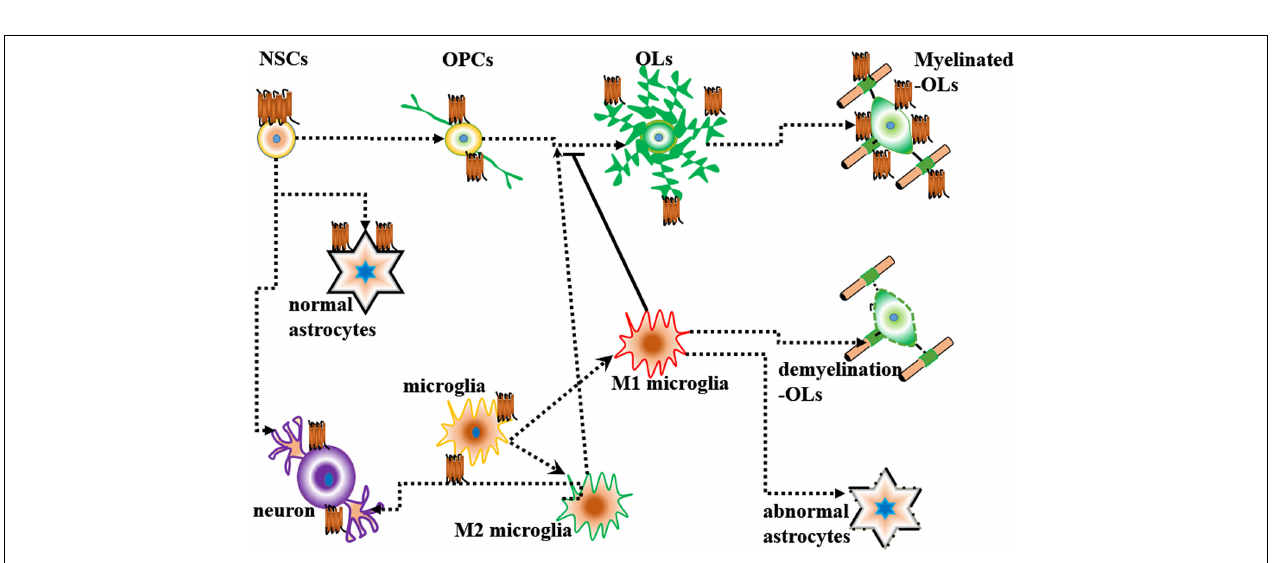
FIGURE 2 | Lpar1/Edg2 is present on various cell types and interacts with glial cells and neurons.